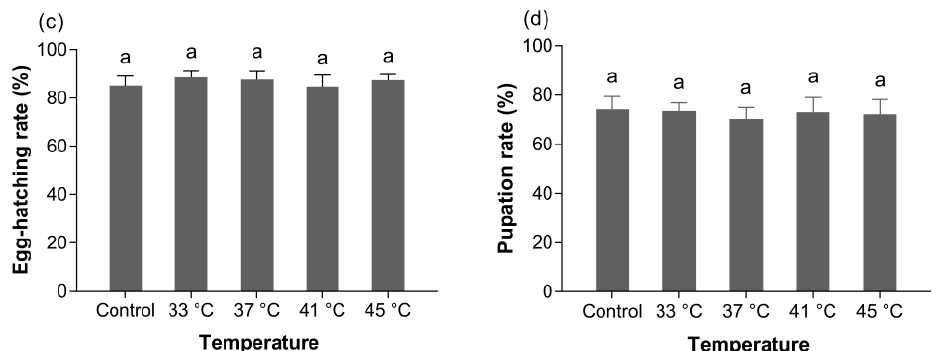
Figure 3. Impact of 1 h short-term heat exposure on the ( a ) mortality, ( b ) fecundity, ( c ) egg-hatching rate, and ( d ) pupation rate of post-storage adults (5 day-old pupae stored at 13 °C). The mean value followed by the same letter does not differ significantly ( P >0.05) according to Tukey’s HSD test (one-way ANOVA).